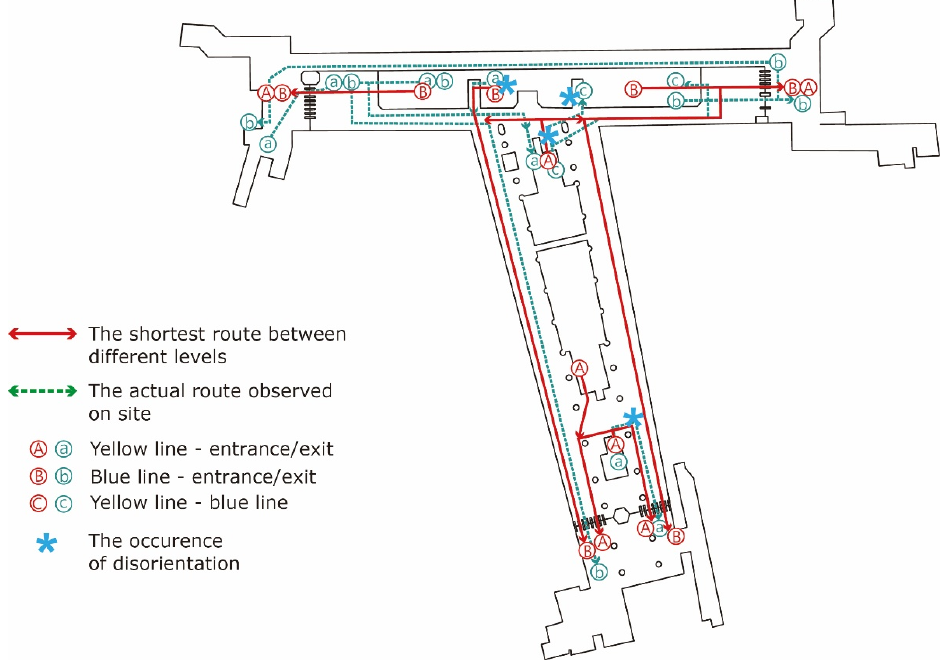
Figure 3. Behavioral pattern of passengers in Zhongxiao Xinsheng.